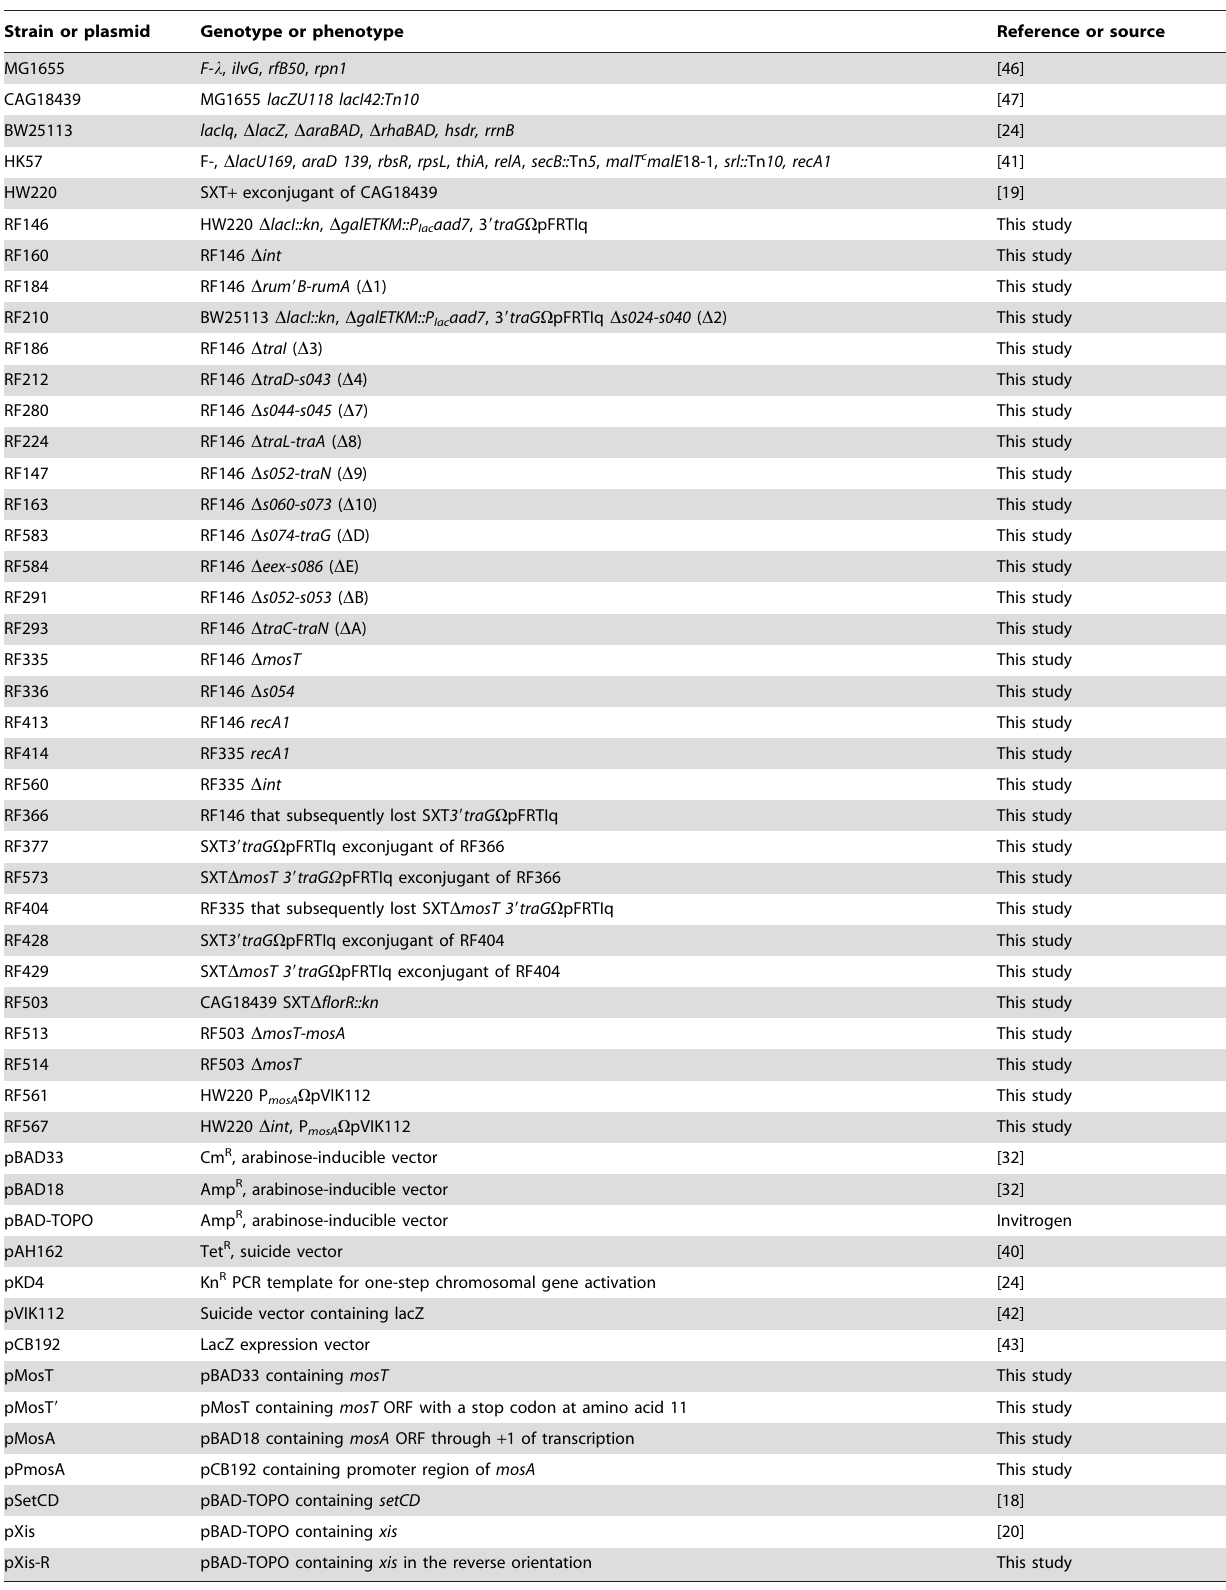
Table 4. Strains and plasmids used in this